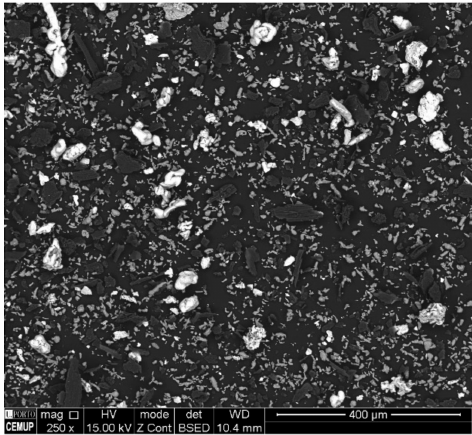
Figure 5. SEM-BSE image of the mixture of the starting powders and binder.